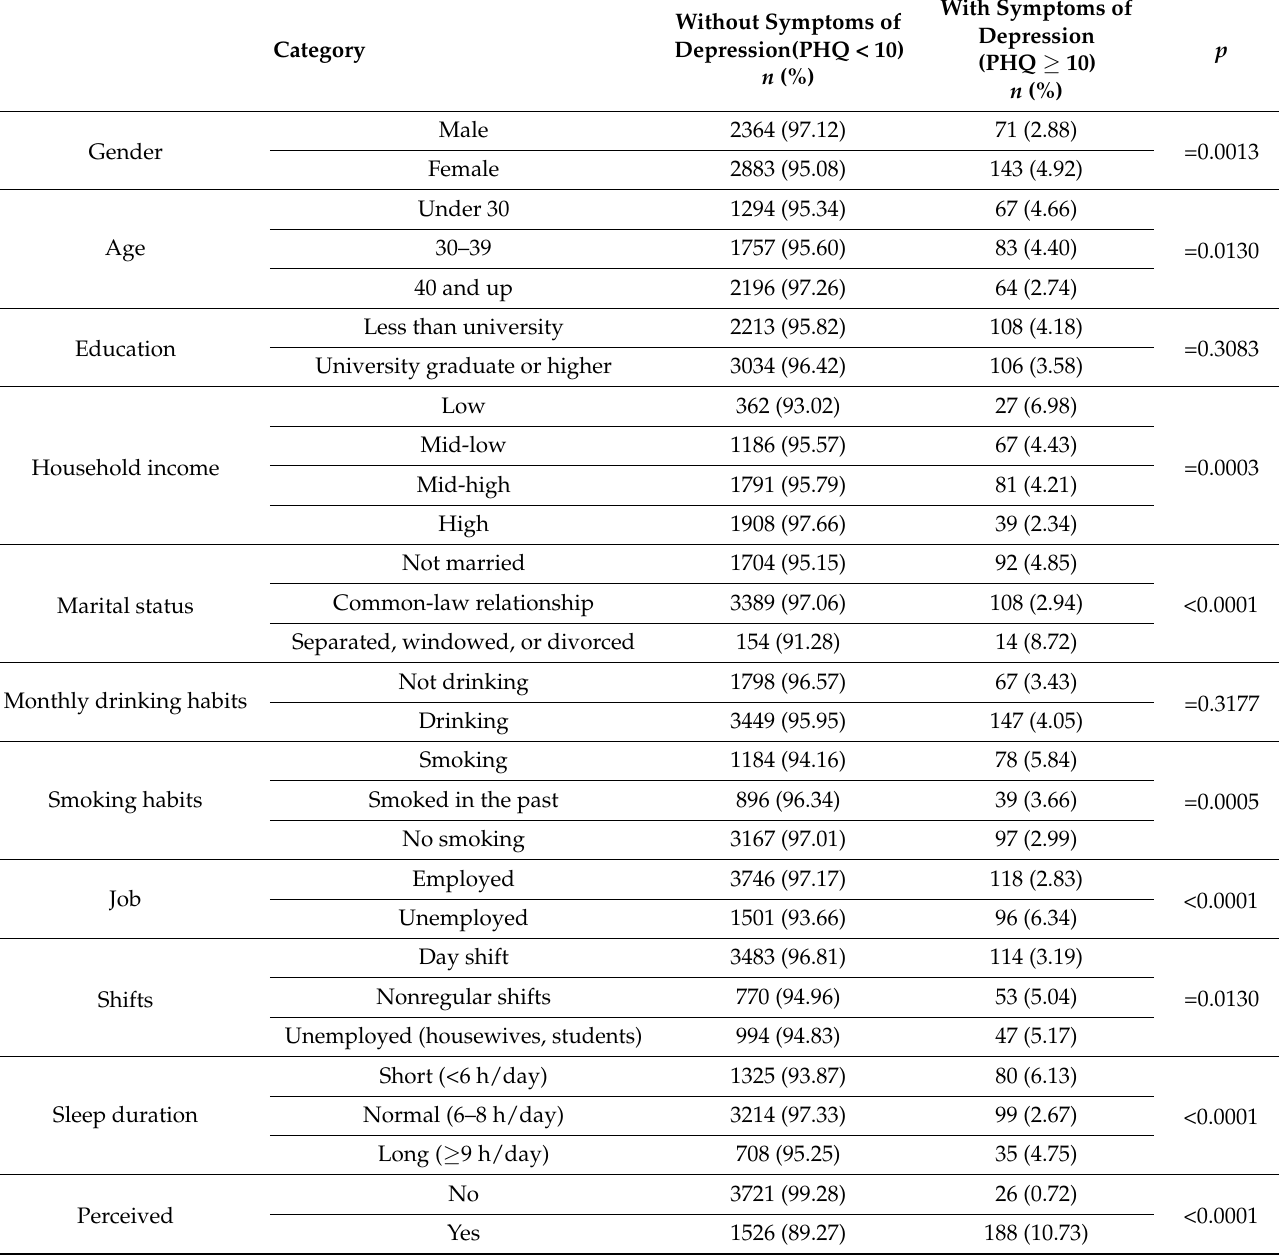
Table 2. A cross-analysis between the demographics and symptoms of